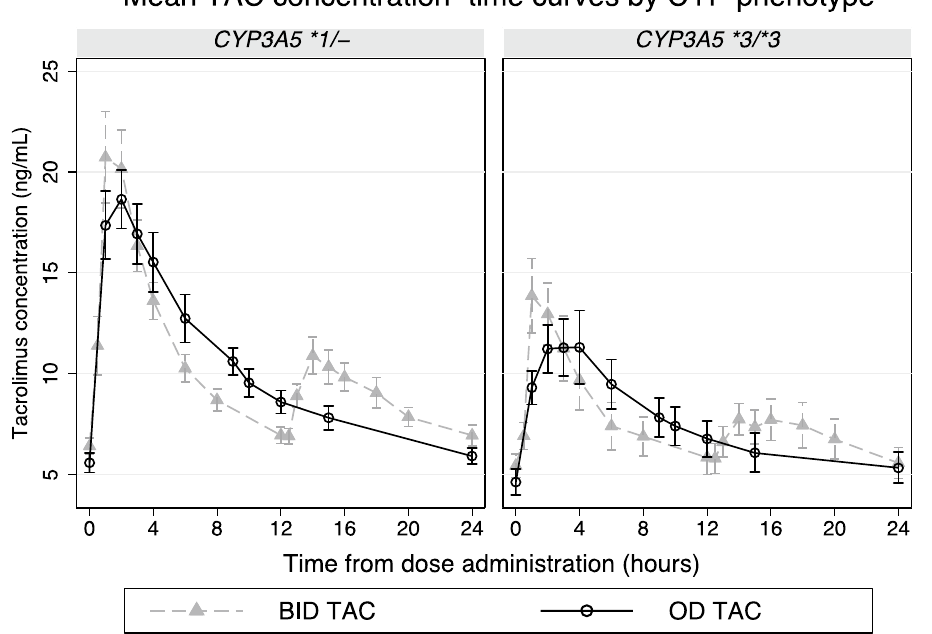
Figure 4. The mean (± SE) tacrolimus concentration–time curves by CYP3A5 genotype of both BID TAC and OD